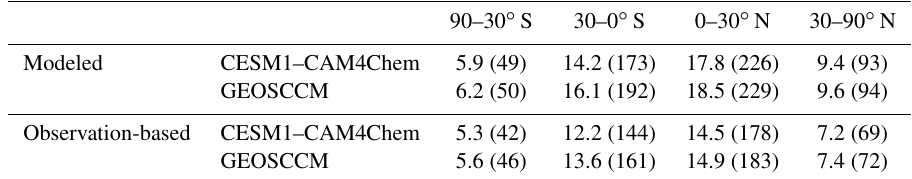
Figure 1. Spatial distributions of air-mass-weighted tropospheric mean OH ([OH] trop-M ) in 2010 from model simulations (a, d) and con- strained by observations (b, e) , and the difference between modeled and observation-based [OH] trop-M (c, f) estimated from CESM1– CAM4Chem (a–c) and GEOSCCM (d–f) simulations. The global mean values are shown in the inset in molec.cm − 3 . Table 3. The modeled and observation-based [OH] trop-M (in 10 5 molec.cm − 3 ) averaged over latitudinal bands during 2000–2009. The corresponding tropospheric CH 4 sink by OH ( L CH ) (in Tgyr − 1 ) is given in 4 + OH